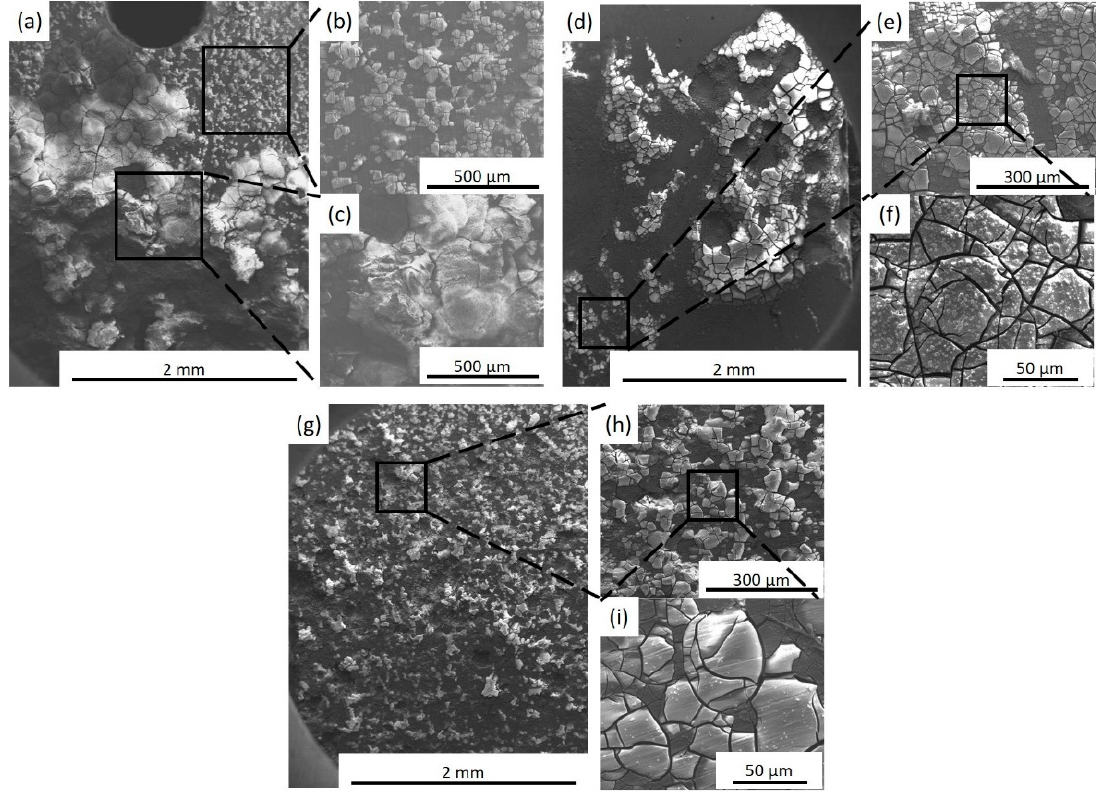
Figure 11. Corrosion morphologies of ( a – c ) BM, ( d – f ) FSP-WE43, and ( g – i ) WE43/nHA specimens after immersion in SBF for 72 h at 37 °C (with corrosion products).